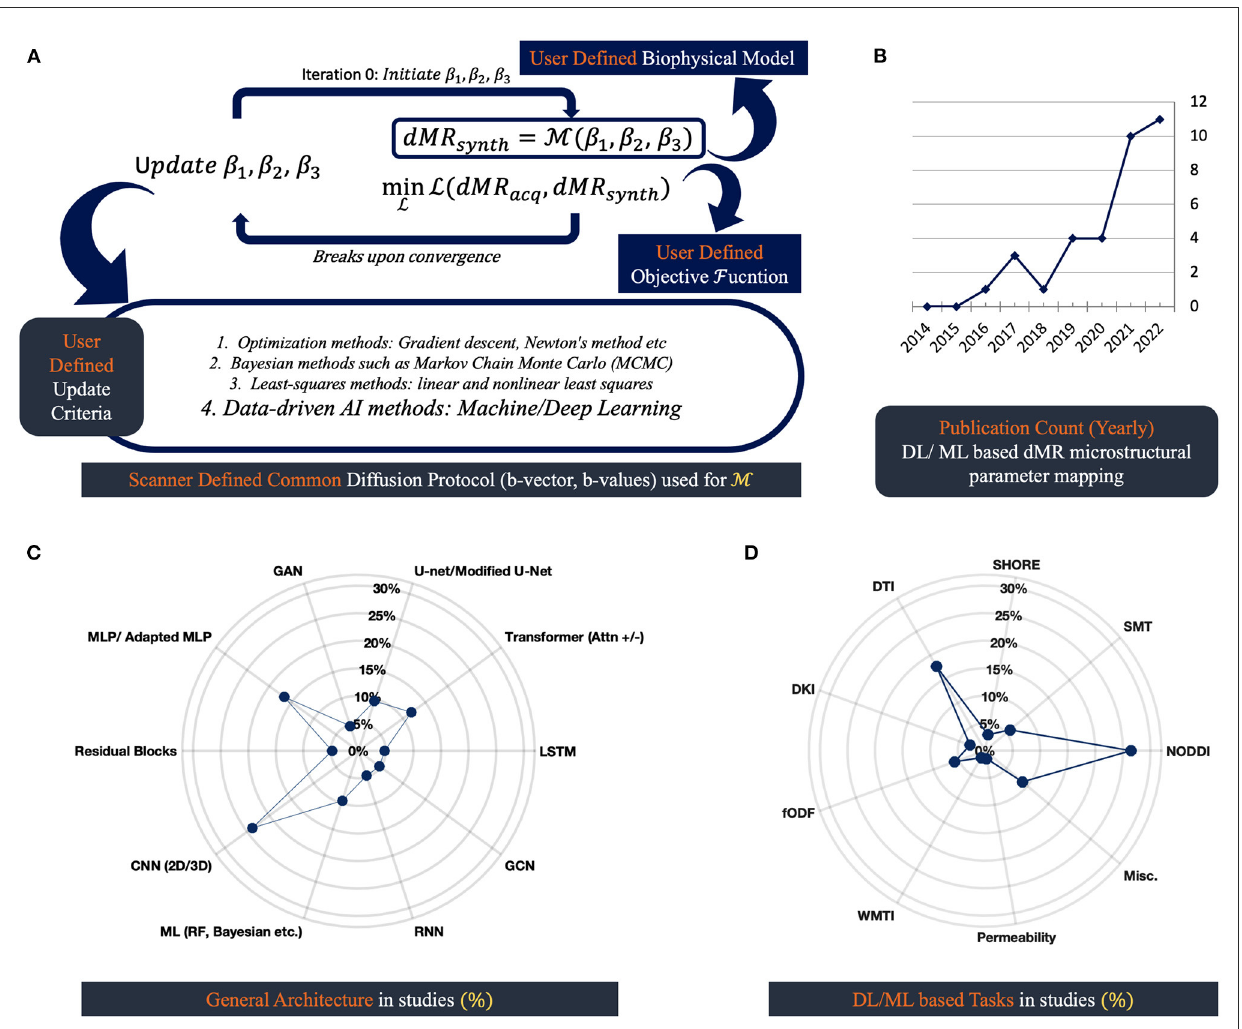
FIGURE1 dMRI based microstructural reconstruction in human brain: schematics and progress through AI: (A) general schematics of microstructural reconstruction using biophysical model; (B) displays the number of AI approaches proposed over the last decade; (C) shows type of architectures these approaches use; (D) shows the biophysical models these AI approaches are applied to.